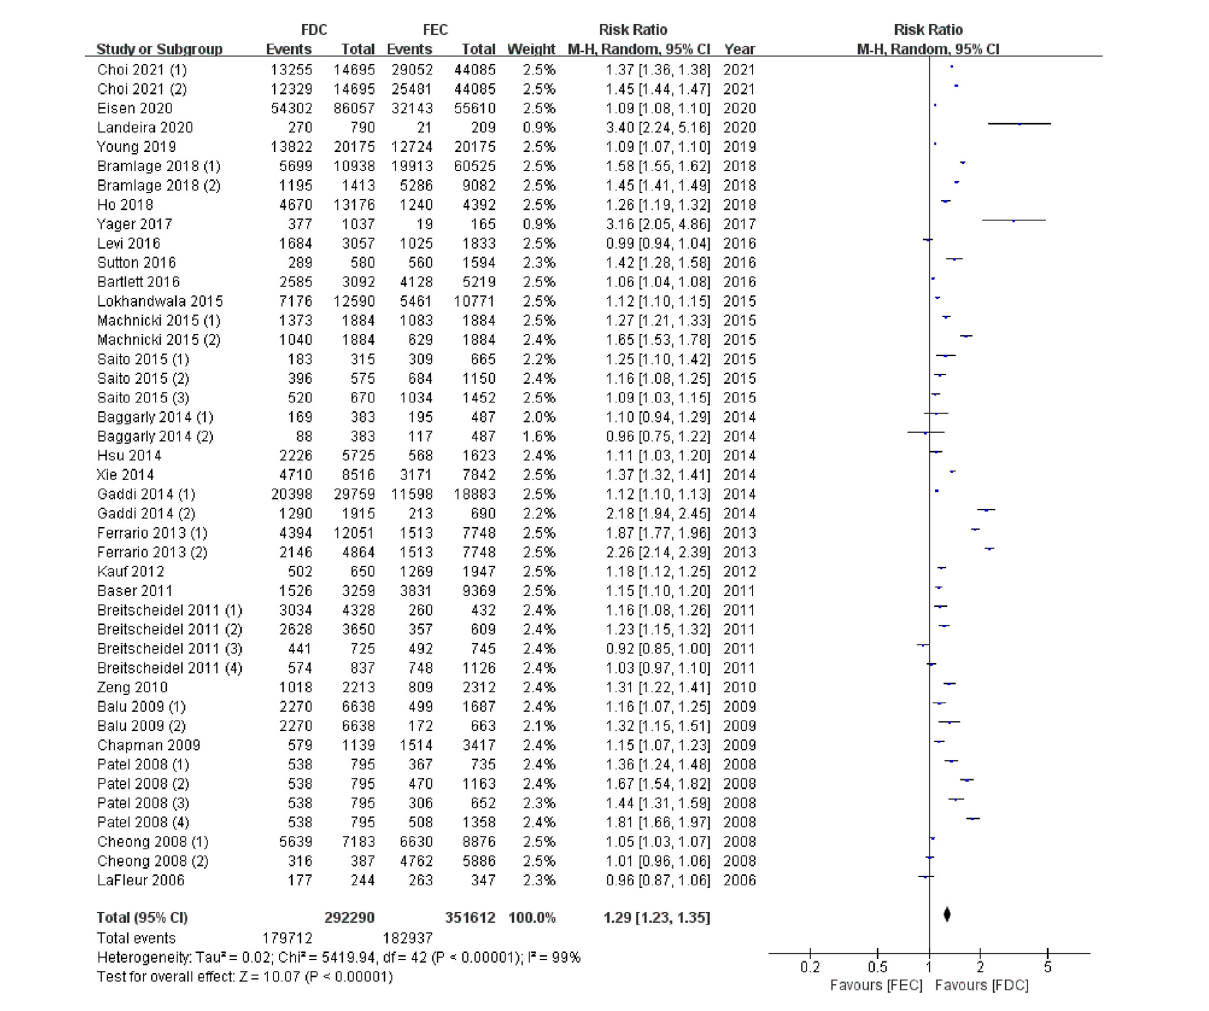
Meta-analysis of risk ratio for medicine high adherents (MPR or PDC ≥ 0.8) in ITT population. MPR: medication possession ratio; PDC: proportion of days covered; FDC: fi xed-dose combination; FEC: free-equivalent components; ITT: Intention-to-treat